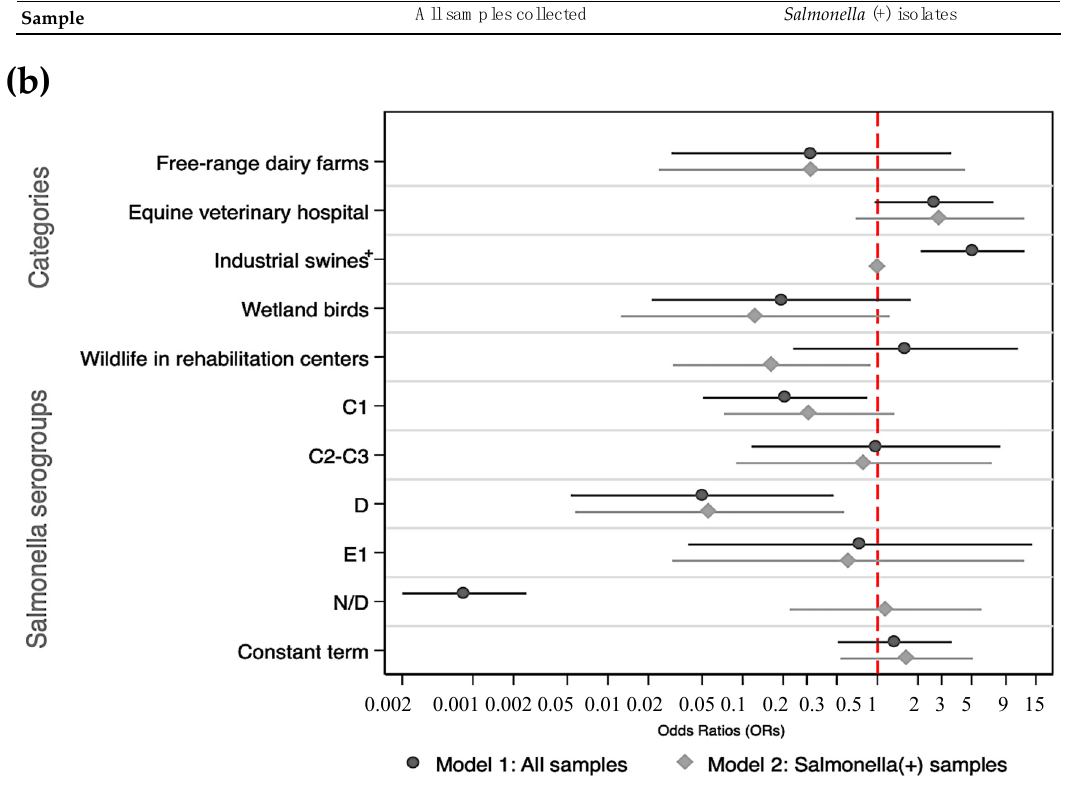
Figure 3. Multivariate logistic regression results, in ( a ) table of results and ( b ) graphical visualization of the model results. Reference group (ref.) stands for backyard chicken farms and serogroup B. Our dependent variable indicates the presence of resistance to at least one antimicrobial for Salmonella . SE stands for standard error, whereas OR is for odds ratios. Pr > |z| is for p -value; a Some categories were dropped as they did not present variation of SDR prevalence (i.e., industrial dairy farms and other backyard animals); b Category dropped in Model 2 due to lack of variation of AMR prevalence. c Robust standard errors were estimated. * p < 0.1, ** p < 0.05, *** p < 0.01.